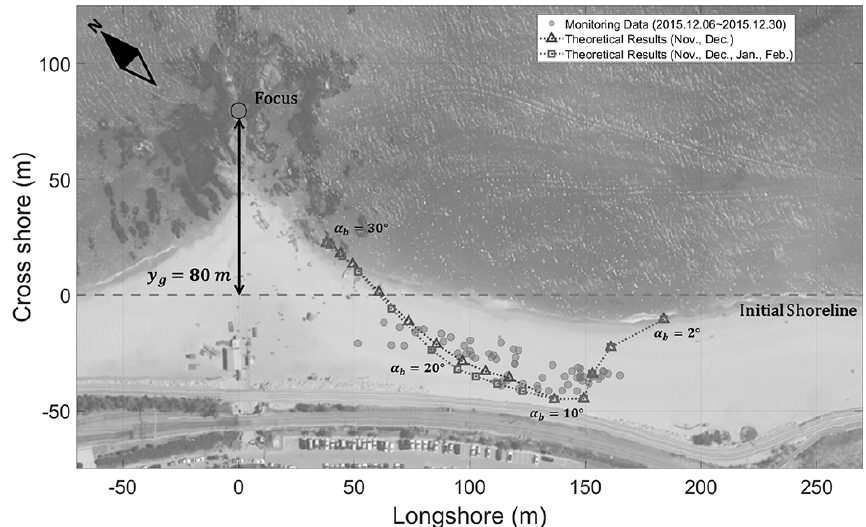
Figure 17. Comparison between video monitoring data and analytical solution © National Geographic Information Institute (NGII).